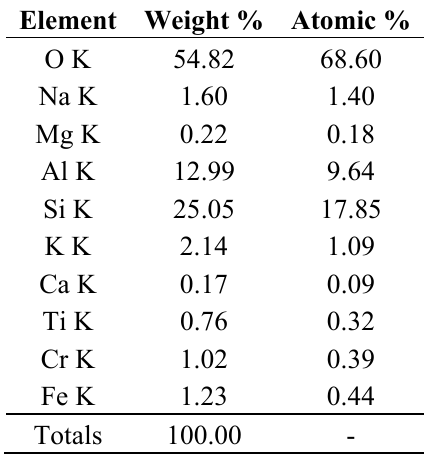
Table 4. Spectrum 2, elemental analysis performed on the area delimited by the white square.